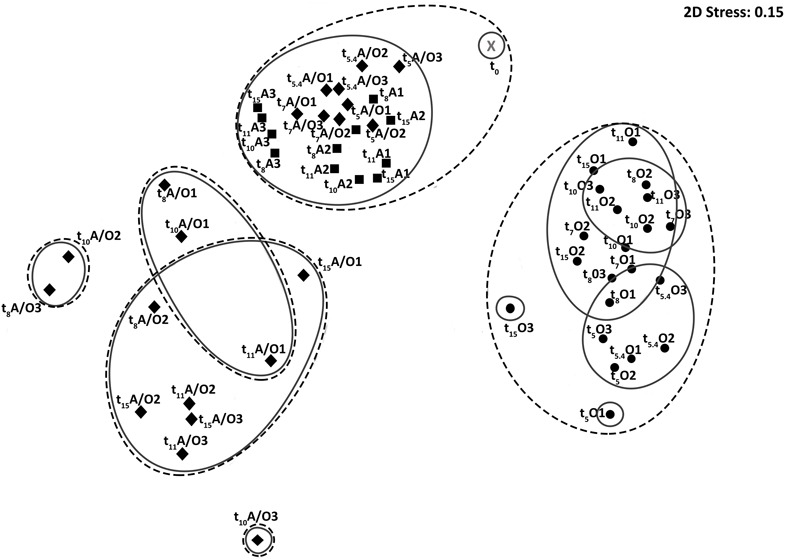
Comparison of the metabolically active bacterial community structures. Non-parametric Multidimensional Scaling (nMDS) based on pyrosequencing data from 16S rRNA gene transcripts obtained during bioreactor incubations under permanent anoxic condition (A, filled squares), anoxic/oxic oscillation condition (A/O, filled diamonds) and permanent oxic condition (O, filled circles). Solid and dotted black lines represent 30 and 20% of Bray-Curtis similarity respectively. Analyses were performed in biological triplicates, which are indicated by a number. Samples are named by time (t0, 5, 5.4, 7, 8, 10, 11, and 15 days), condition (A, anoxic; A/O, anoxic/oxic oscillation and O, oxic) and replicate number (1, 2, and 3).